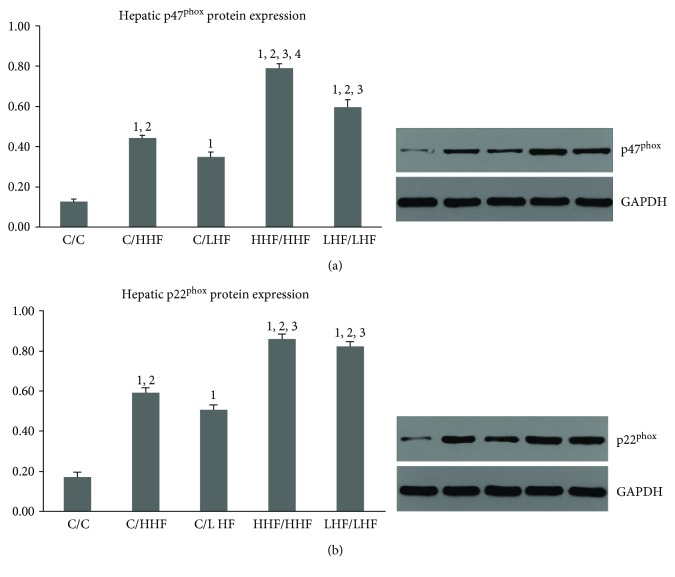
The protein expressions of hepatic p47phox and p22phox in offspring mice of different groups. Values are mean ± SD (n = 6). (a) The protein expression of hepatic p47phox; (b) the protein expression of hepatic p22phox. 1p < 0.01 versus C/C group; 2p < 0.01 versus C/LHF group; 3p < 0.01 versus C/HHF group; 4p < 0.01 versus LHF/LHF group.